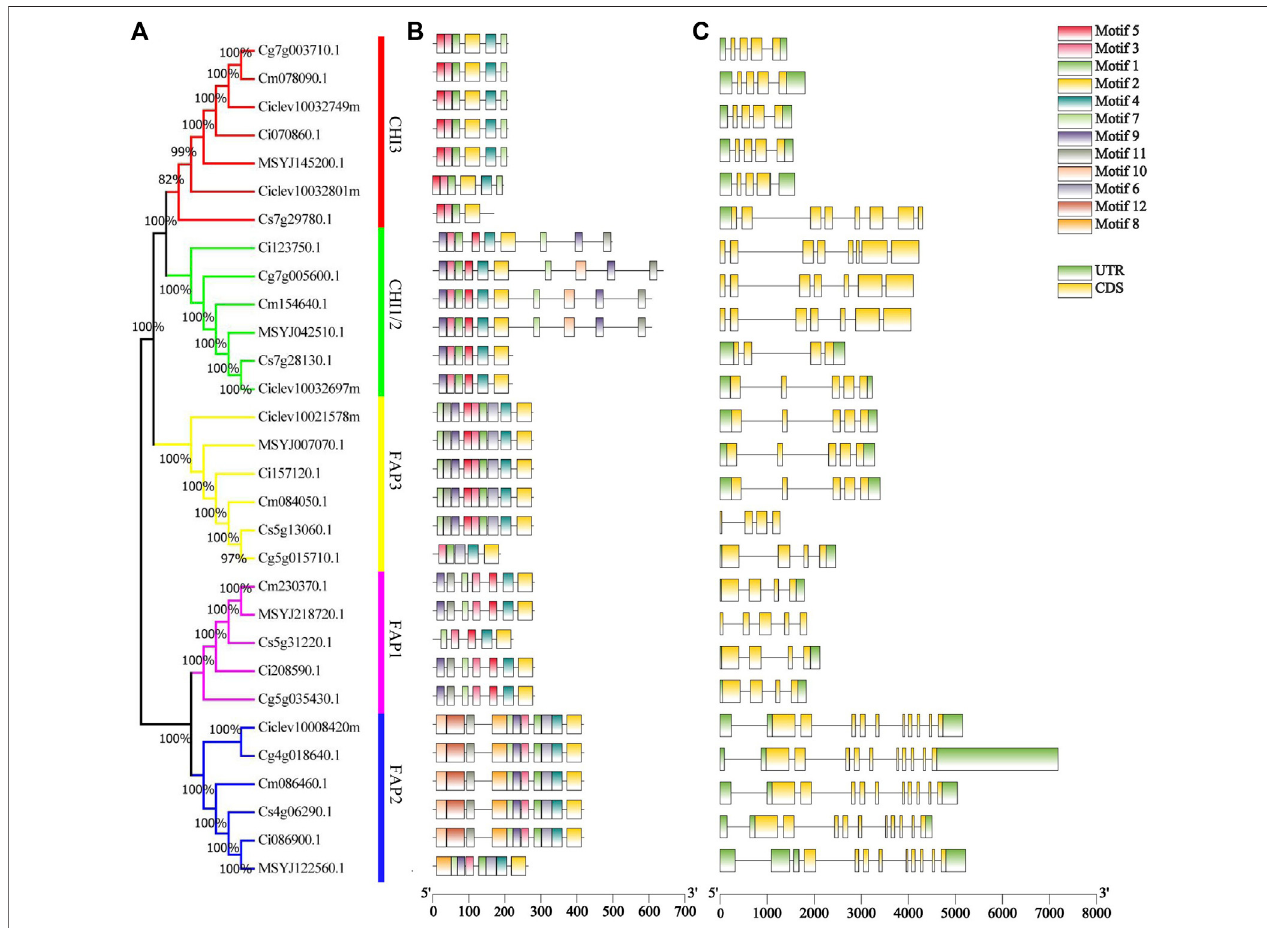
FIGURE 1 | Characterization of 30 Citrus chalcone domain proteins. (A) Phylogenetic tree of 30 chalcone domain protein sequences. (B) Conserved motifs of chalconedomainproteins.Differentcoloredboxesrepresentdifferentmotifs. (C) Genestructuresofchalconedomainproteingenes.Greylinesrepresent introns,yellow boxes represent exons, and green boxes represent